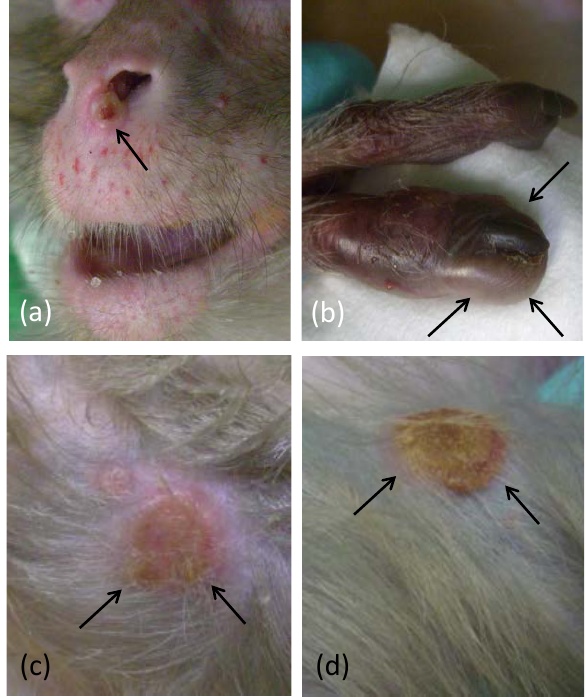
Figure 1. Dermal lesions at different time points after i.v. calpox infection, Macaca mulatta , animal no. 2. (a) Focal umbilicated pus- tular lesion beneath the nose, 17 days p.i. (arrows). (b) Severe focal papular dermatitis of the left trigger finger, 17 days p.i. (arrows). (c) Severe focal ulcerative dermatitis of the right arm induced by confluent pustules, 17 days p.i. (arrows). (d) Severe focal ulcerative dermatitis of the right arm covered by a crust, 21 days p.i.